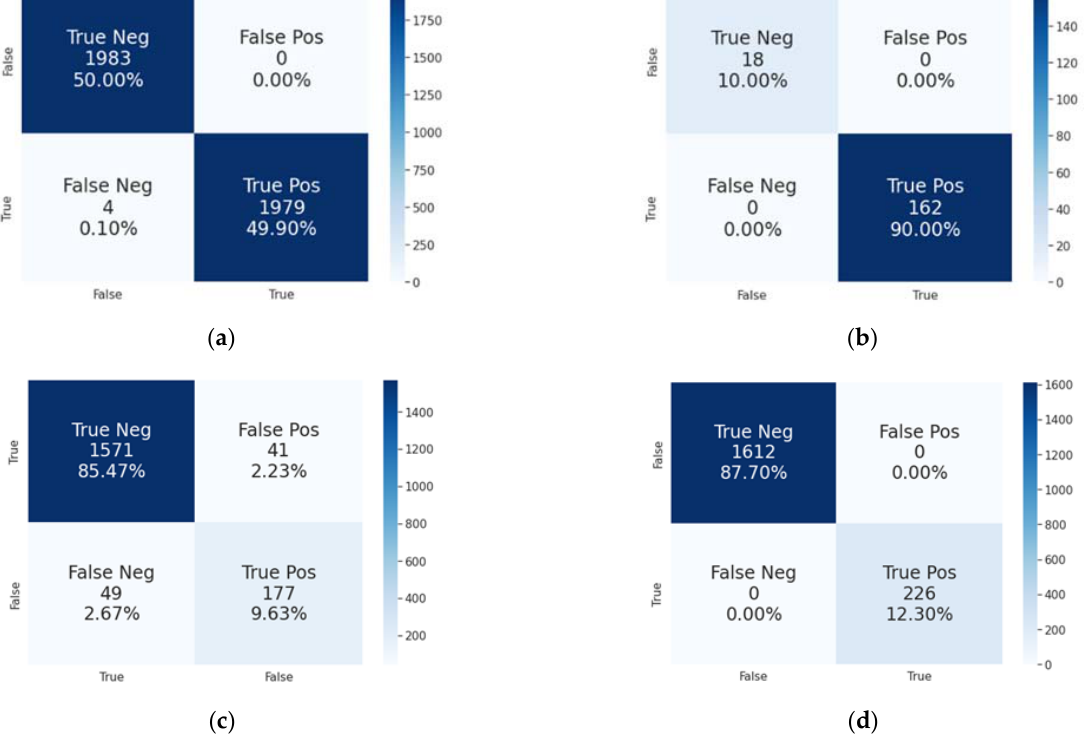
Figure 9. Confusion matrices for the: ( a ) training data from the MIT-BIH database; ( b ) testing data collected from the ambulatory sensor (Savvy ECG); ( c ) NSR testing data from the INCART database; ( d ) PVC training and testing data from the INCART database.